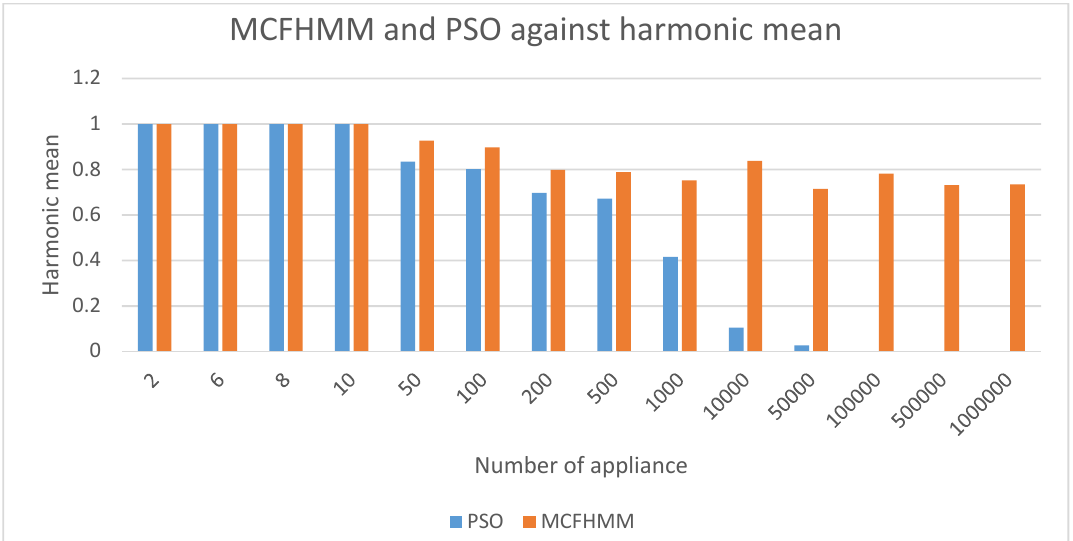
Figure 8. Harmonic mean of MCFHMM and particle optimization swarm